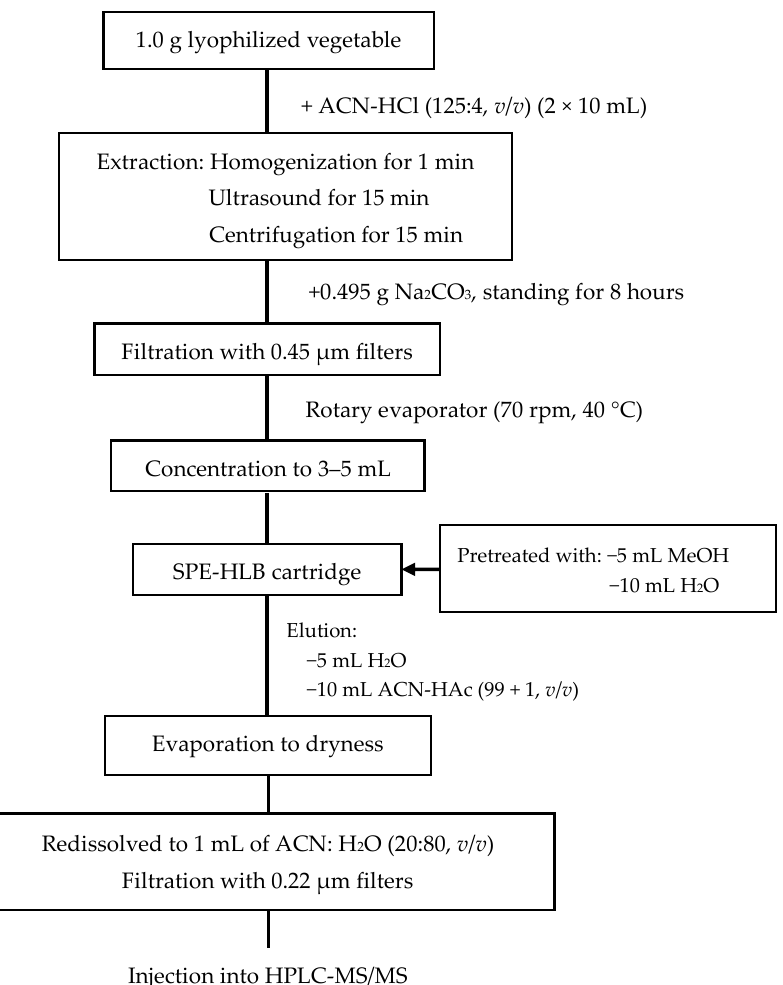
Figure 3. Procedure used for extraction of antibiotics. Optimized extraction, clean-up, and elution procedures developed in the present study are